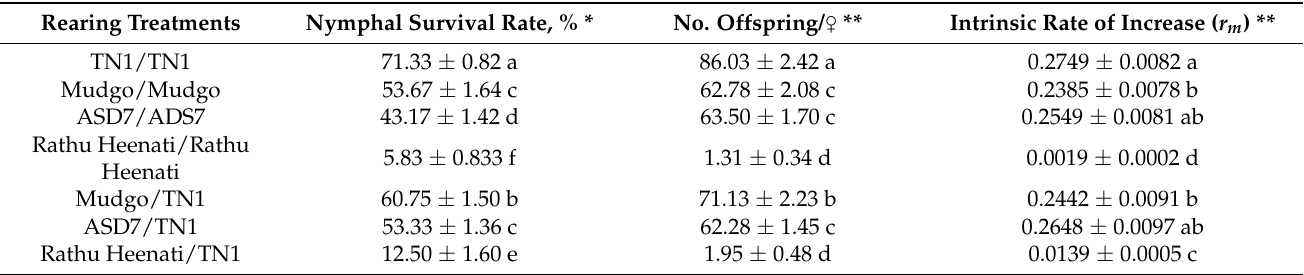
Table 1. Effect of different rearing treatments on the development of first-generation